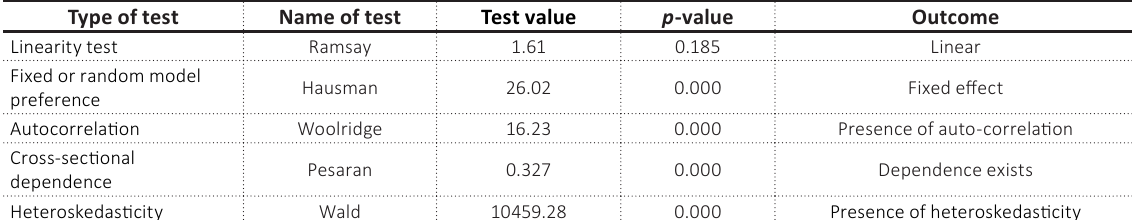
Table 4. Model tests